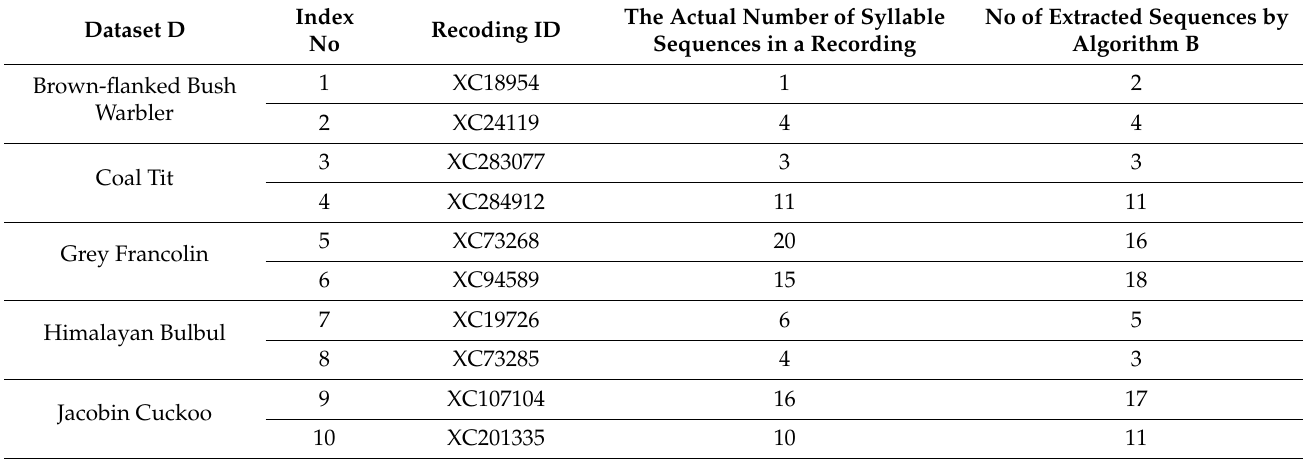
Table 3. Comparison of segmentation results for the sequence of syllables of Monosyllabic Birds. Dataset